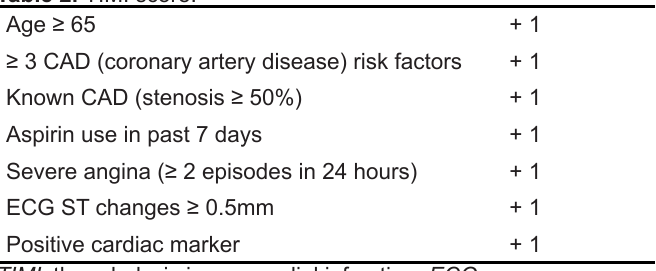
Table 2. TIMI score.